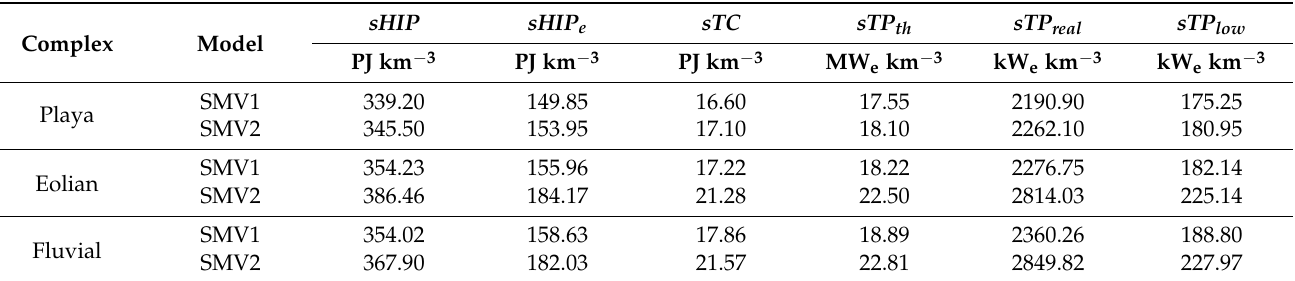
Table 7. Specific geothermal resources of Rotliegend complexes in Kłecko Anticline assessed for models SMV1 and SMV2 in relation to the volume of 1 km 3